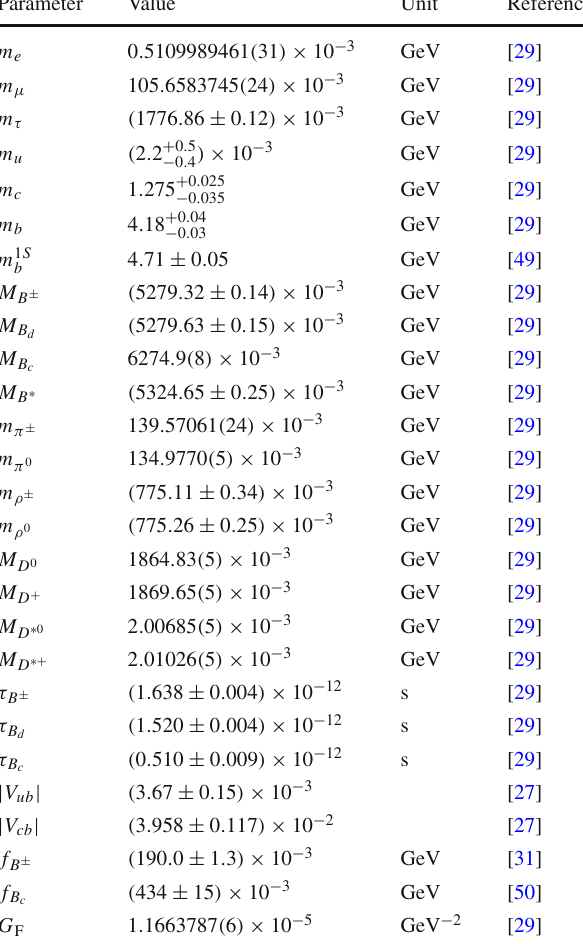
Table 19 Collection of input parameters used in this paper